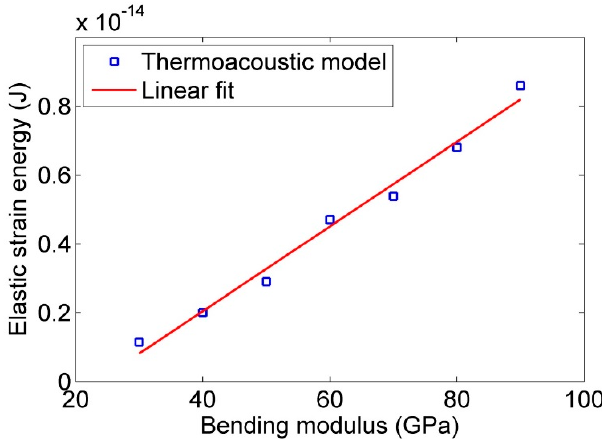
Figure 9. Effect of bending modulus on the normal stress at the clamp end of a nanowire. The analytical model corresponds to the results of the thermoacoustic model ( σ ∝ E ).